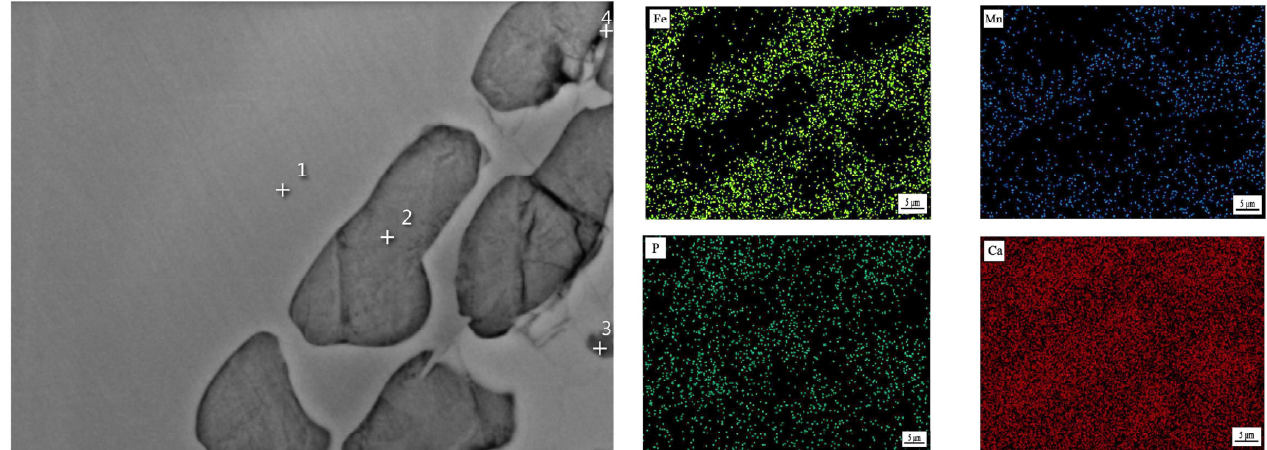
Figure 3. Sr‑0 SEM morphology, surface sweep, and energy spectra of four